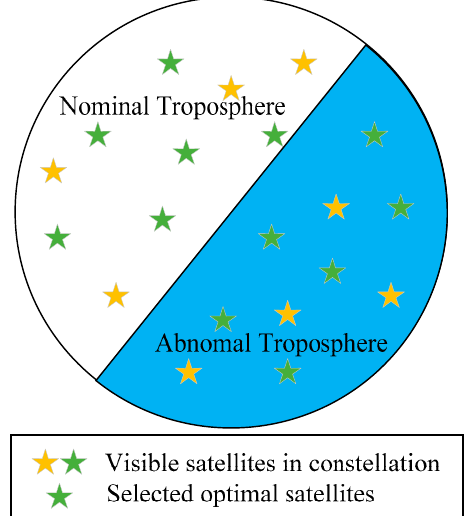
Figure 2. Representation of a skyplot of the selected optimal satellites under abnormal troposphere.